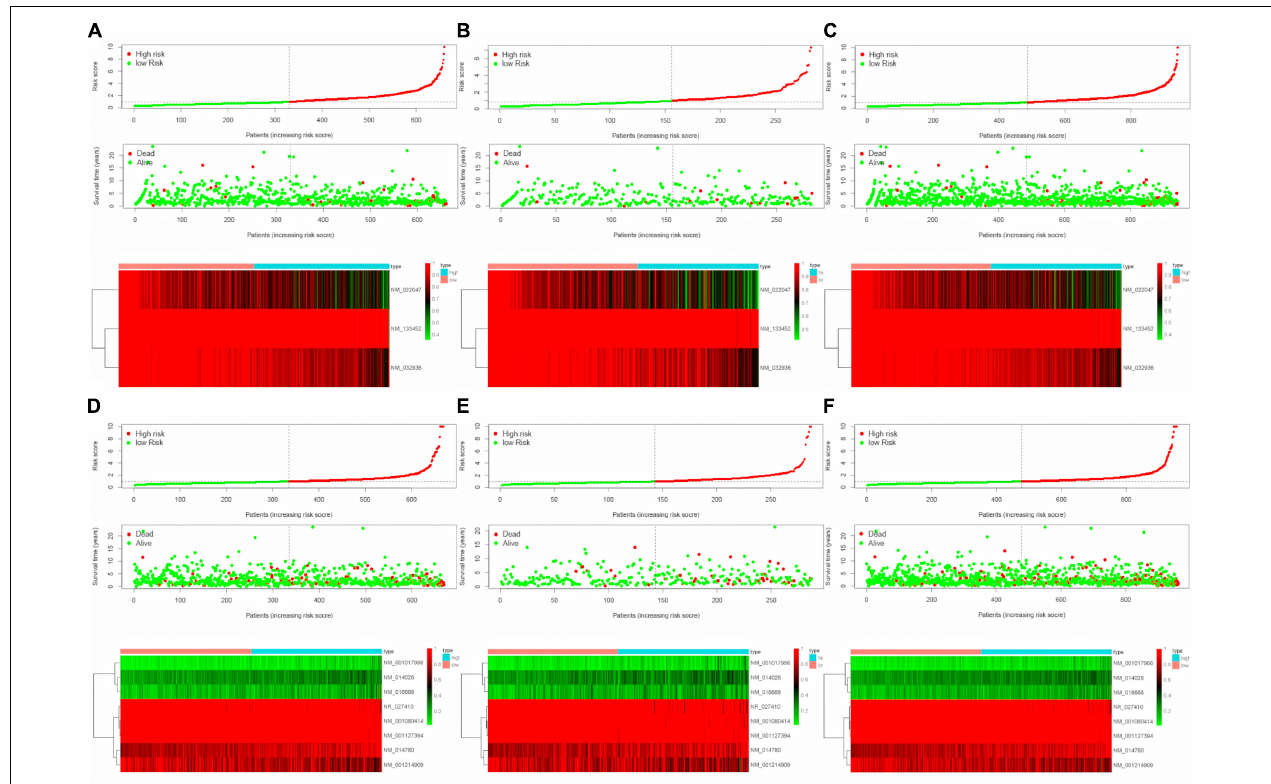
FIGURE 2 | Construction of multivariate Cox proportional hazards regression models. (A–C) Distribution of risk score, status, and APA events heatmap for OS in the training set, test set, and whole set. (D–F) Distribution of risk score, status and APA events heatmap for RFS in the training, test and whole